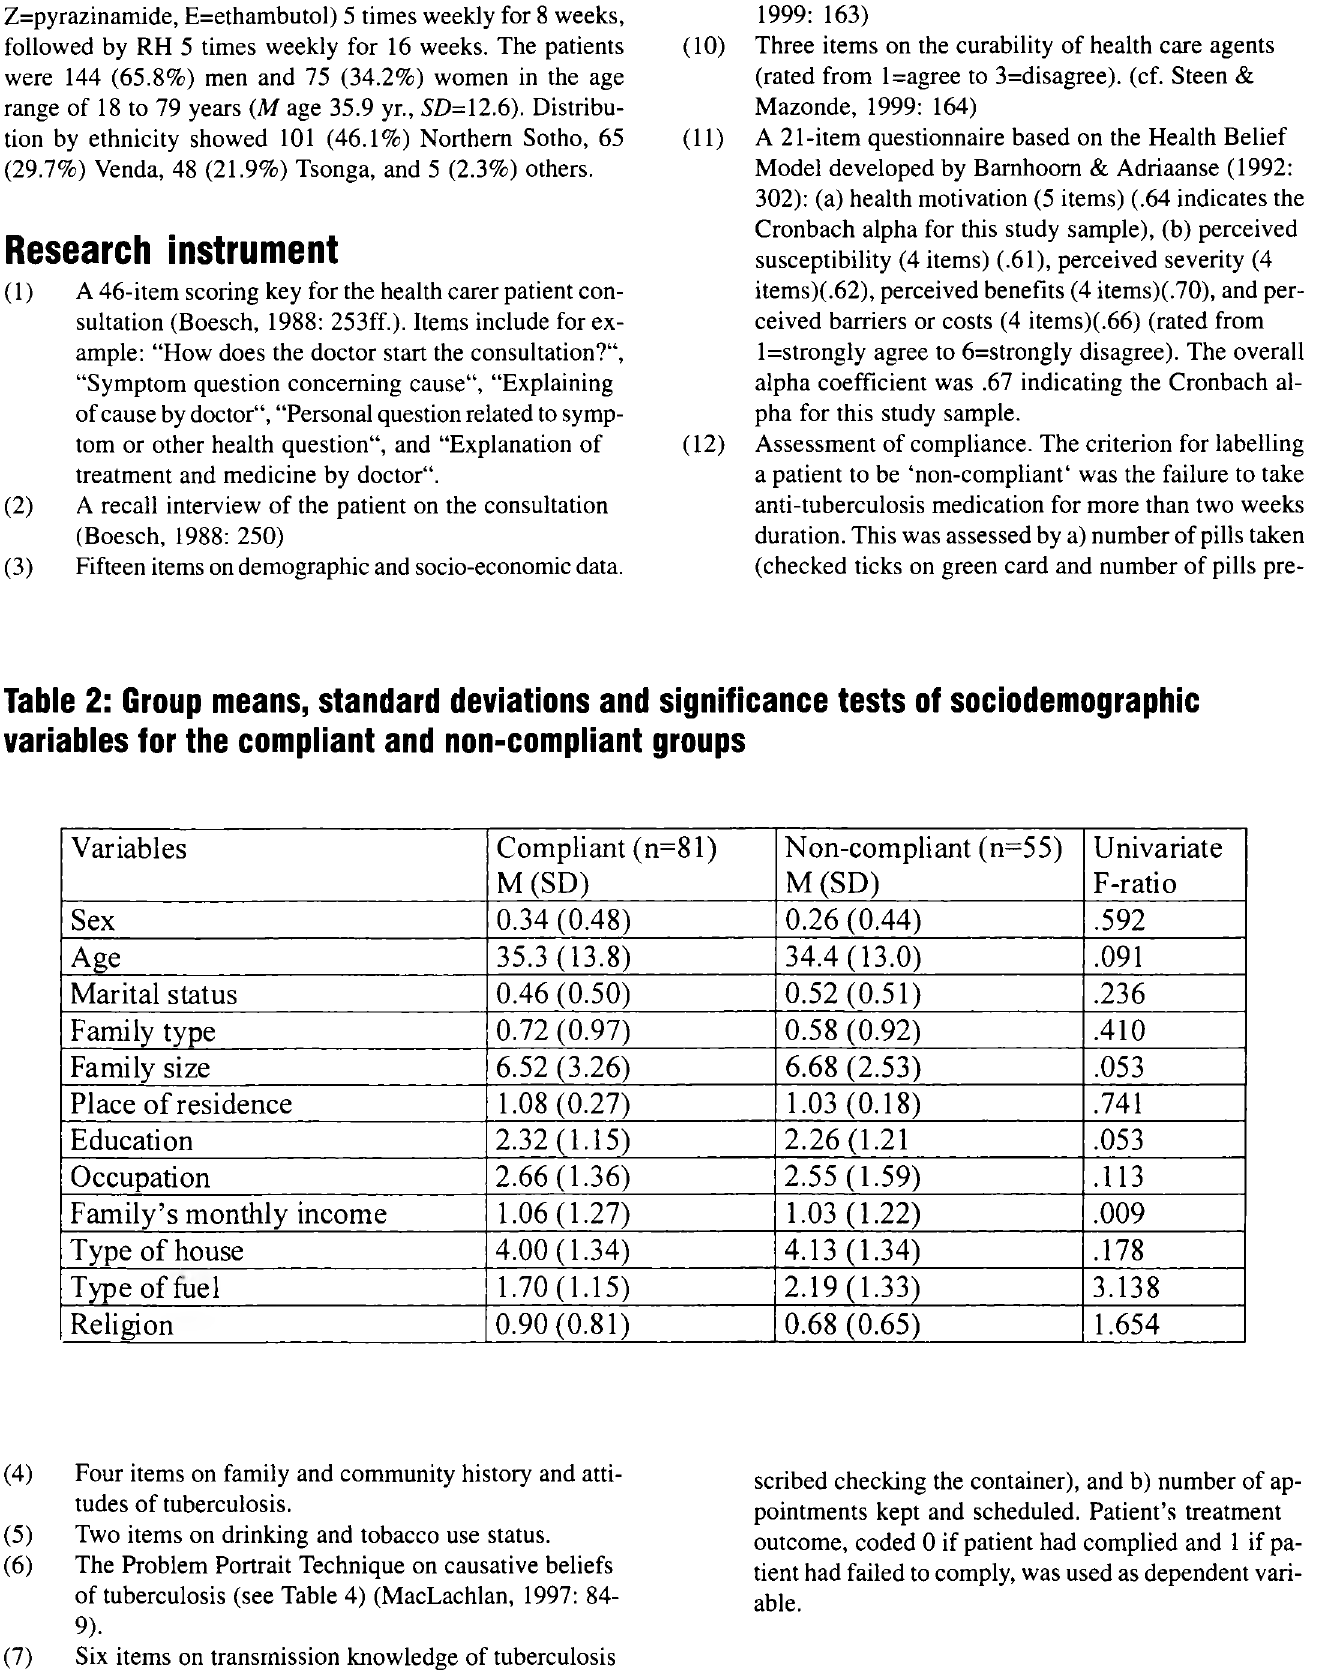
Table 2: Group means, standard deviations and significance tests of sociodemographic variables for the compliant and non-compliant groups